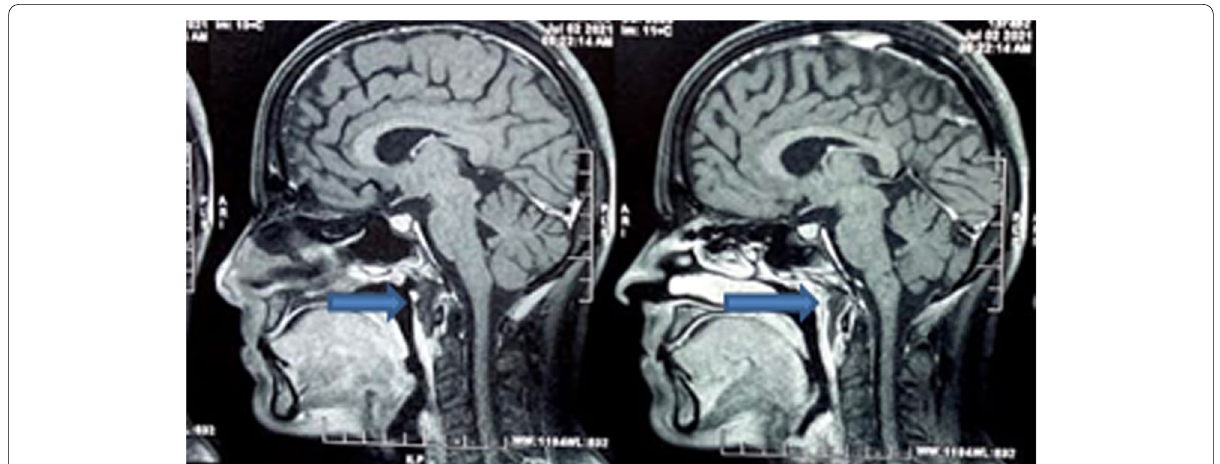
Fig. 1 T1 contrast MRI image (Sagittal section) showing retropharyngeal abscess with no contrast uptake